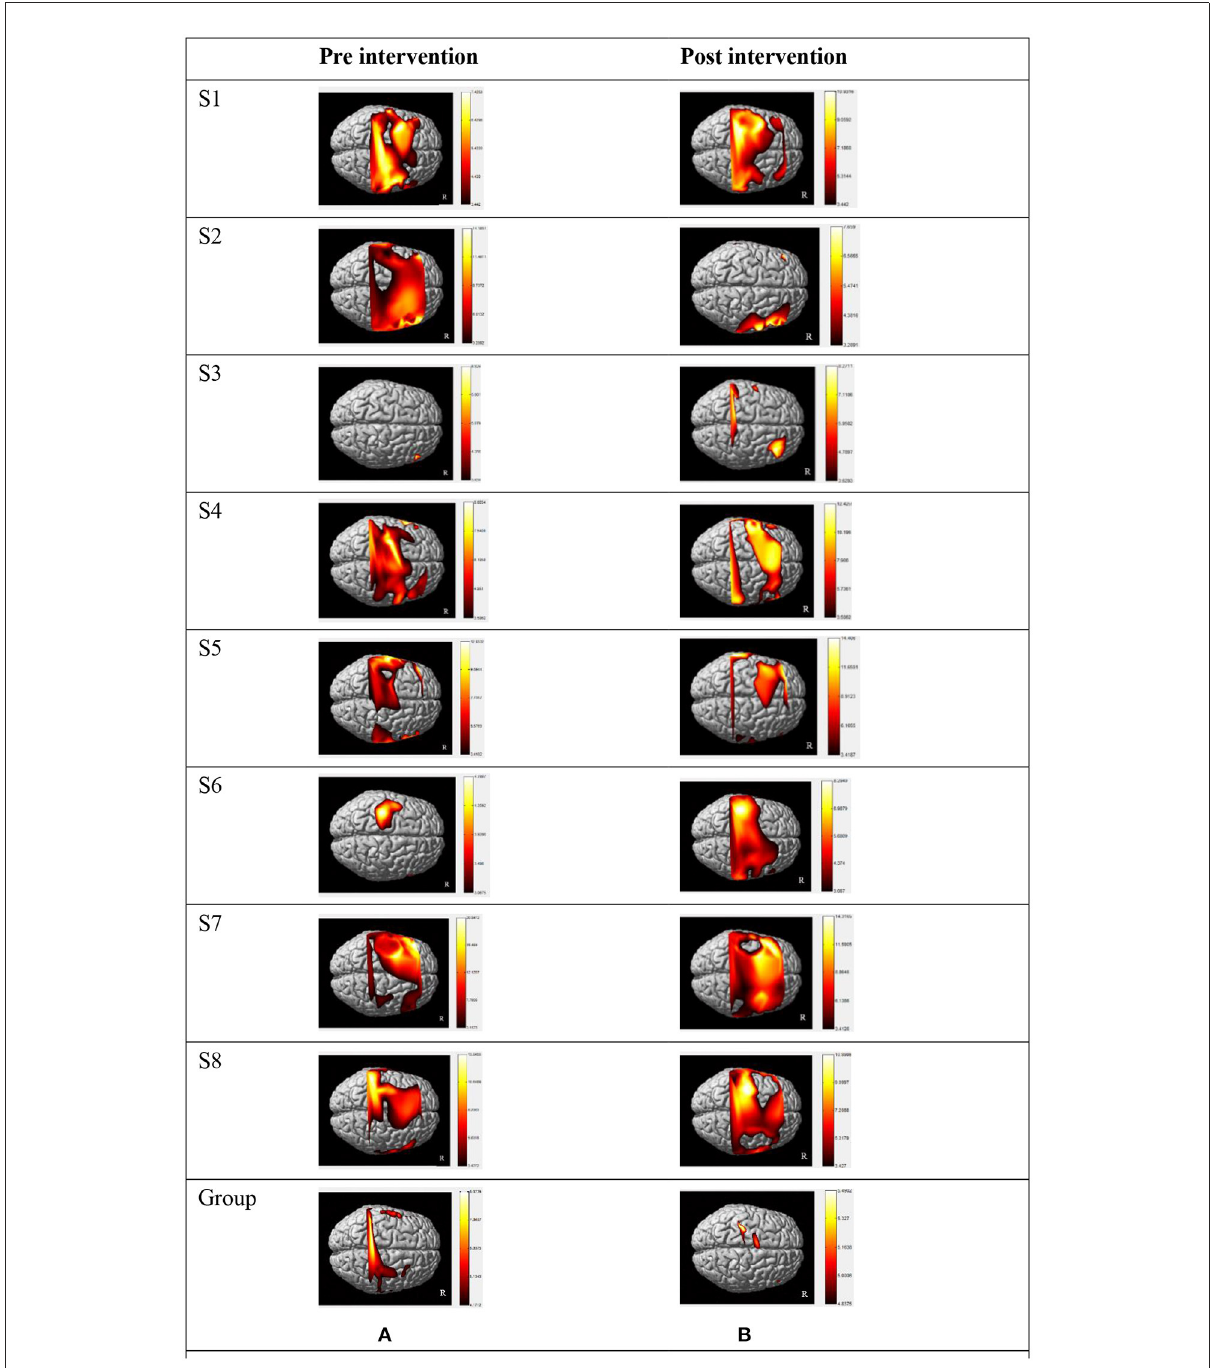
FIGURE3 Individual activation maps and group activation maps of HbO during a motor task generated using the NIRS-SPM pre (A) and post (B) intervention. Patients exhibited high activity levels (yellow color) in different brain areas. (A) Individual and group activation dorsal view map of HbO during grip-release task in pre intervention generated using the NIRS-SPM ( p < 0.05). (B) Individual and group activation dorsal view map of HbO during grip-release task in post intervention generated using the NIRS-SPM ( p < 0.05). S1–S8: the eight patients in this study. Right side of figures represents right side of the subjects. Group: all participant’s group activation dorsal view map of HbO in pre and post R: